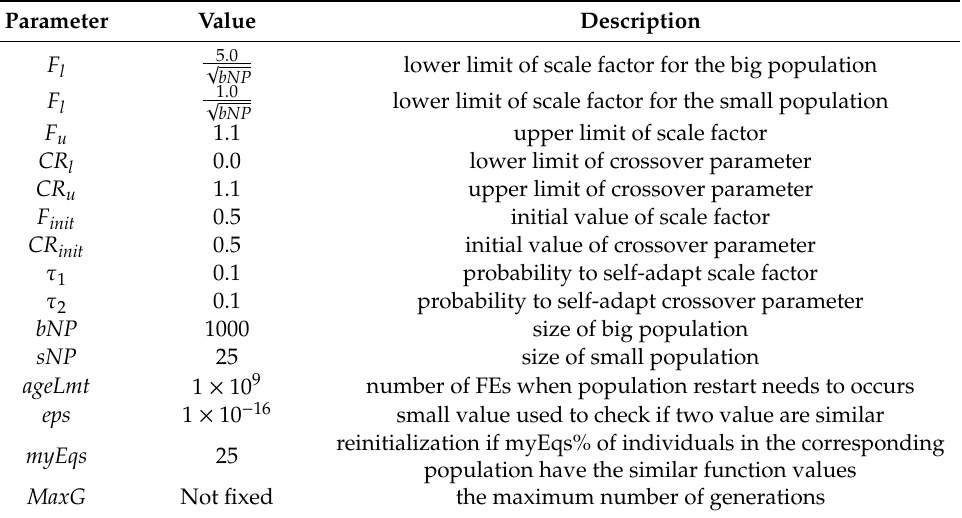
Table 6. Parameter setting of